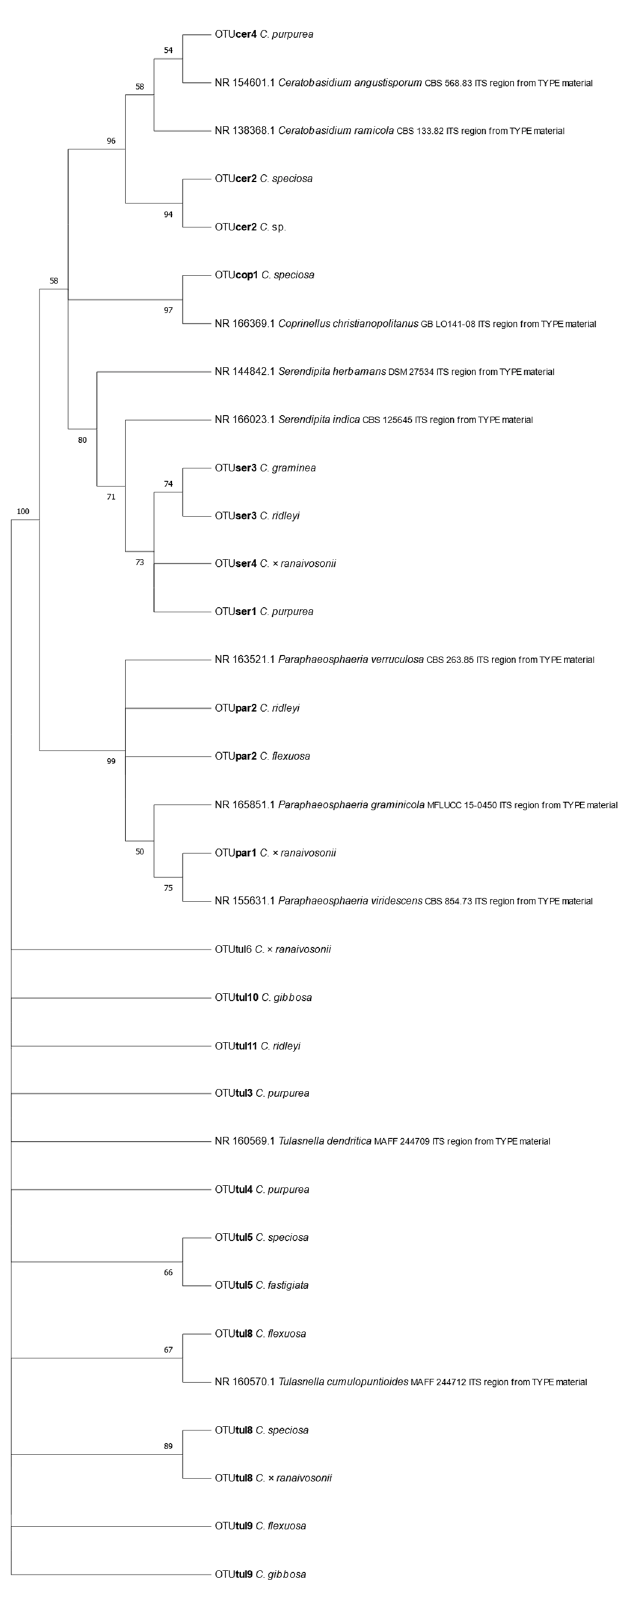
Figure 4. Phylogenetic tree of putative Rhizoctonia mycorrhizal fungi (cer— Ceratobasidium , ser— Serendipita, and tul— Tulasnella ), non- Rhizoctonia fungi such as Coprinellus and Paraphaeosphaeria and their hosts.